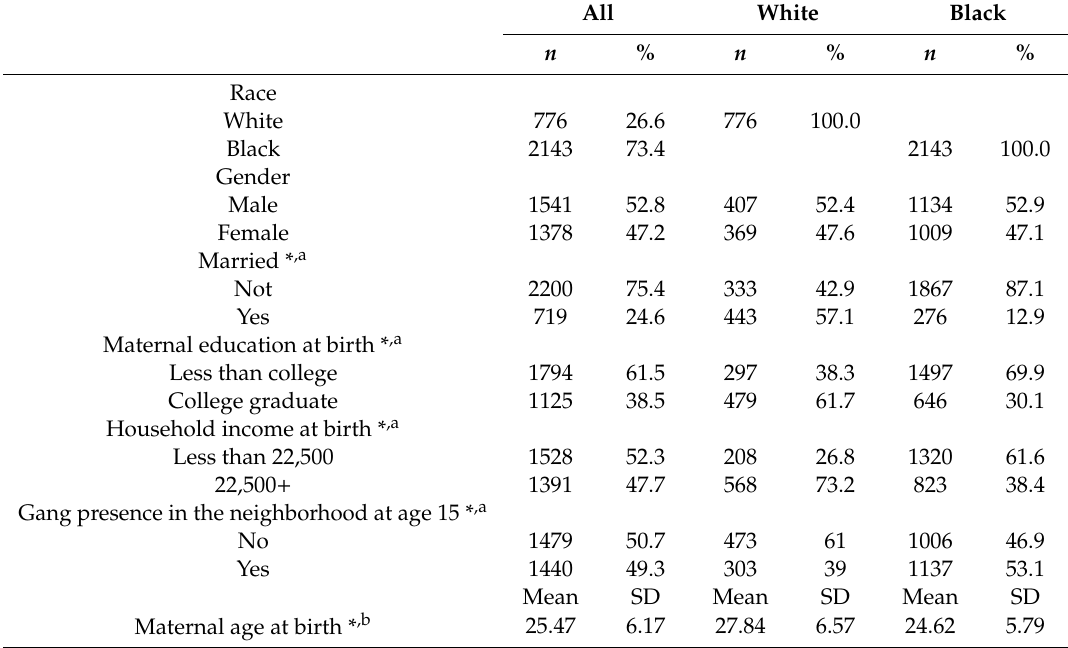
Table 1. Descriptive overall and by race ( n = 2919).